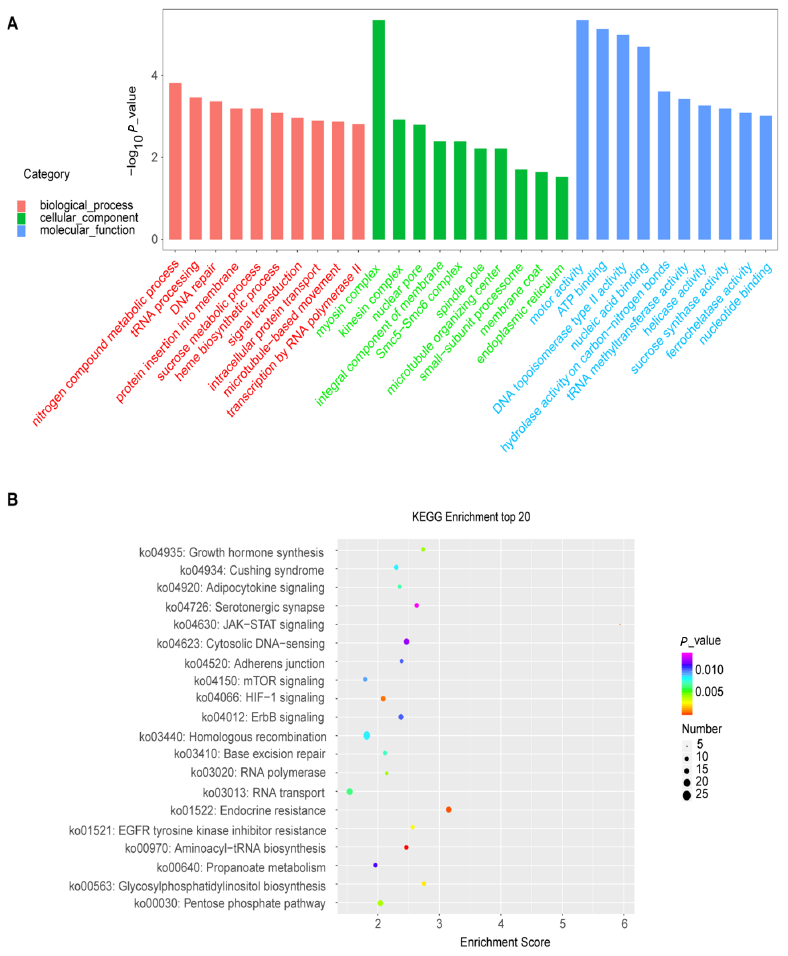
Figure 7. GO and KEGG analyses performed on the ARF4. ( A ), GO analysis showing the top 20 enriched pathways for the biological process, cellular component, and molecular function. ( B ), KEGG analysis displaying the top 20 enriched metabolic pathways based on the ARF4 gate.